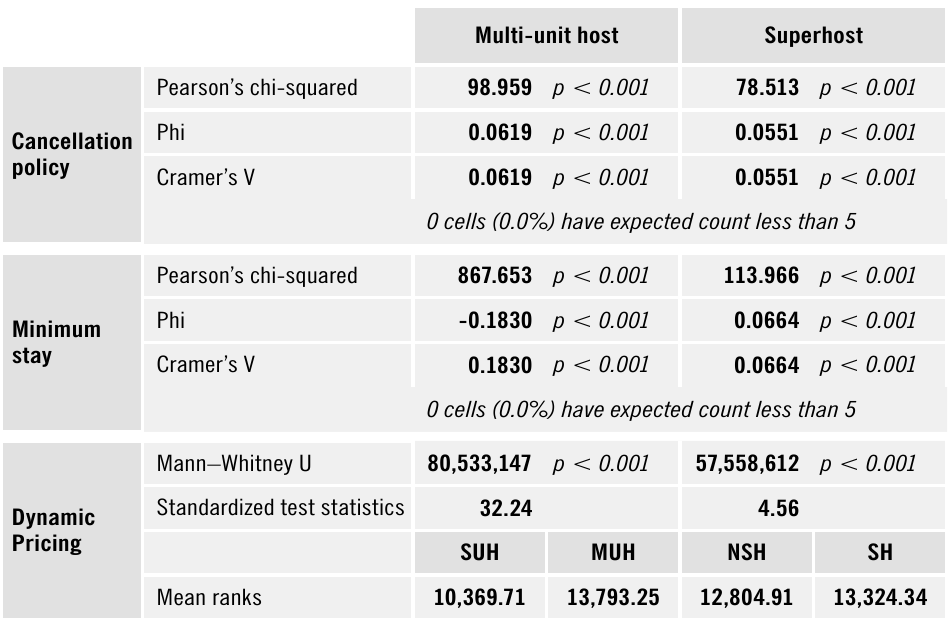
Table 7. Chi-squared and Mann–Whitney U tests